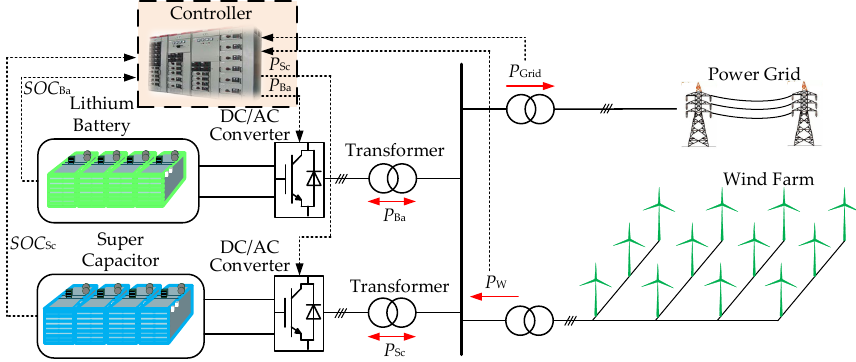
Figure 1. Structure of wind power system containing HESS.